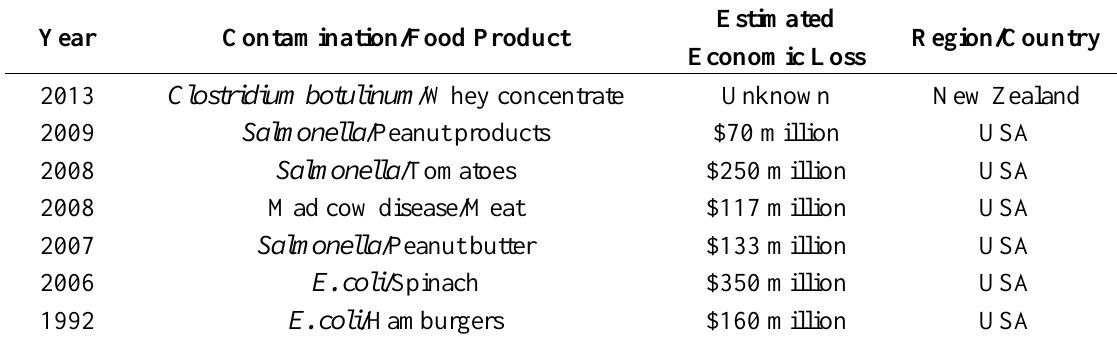
Table 1. World examples of some expensive food outbreaks/recalls